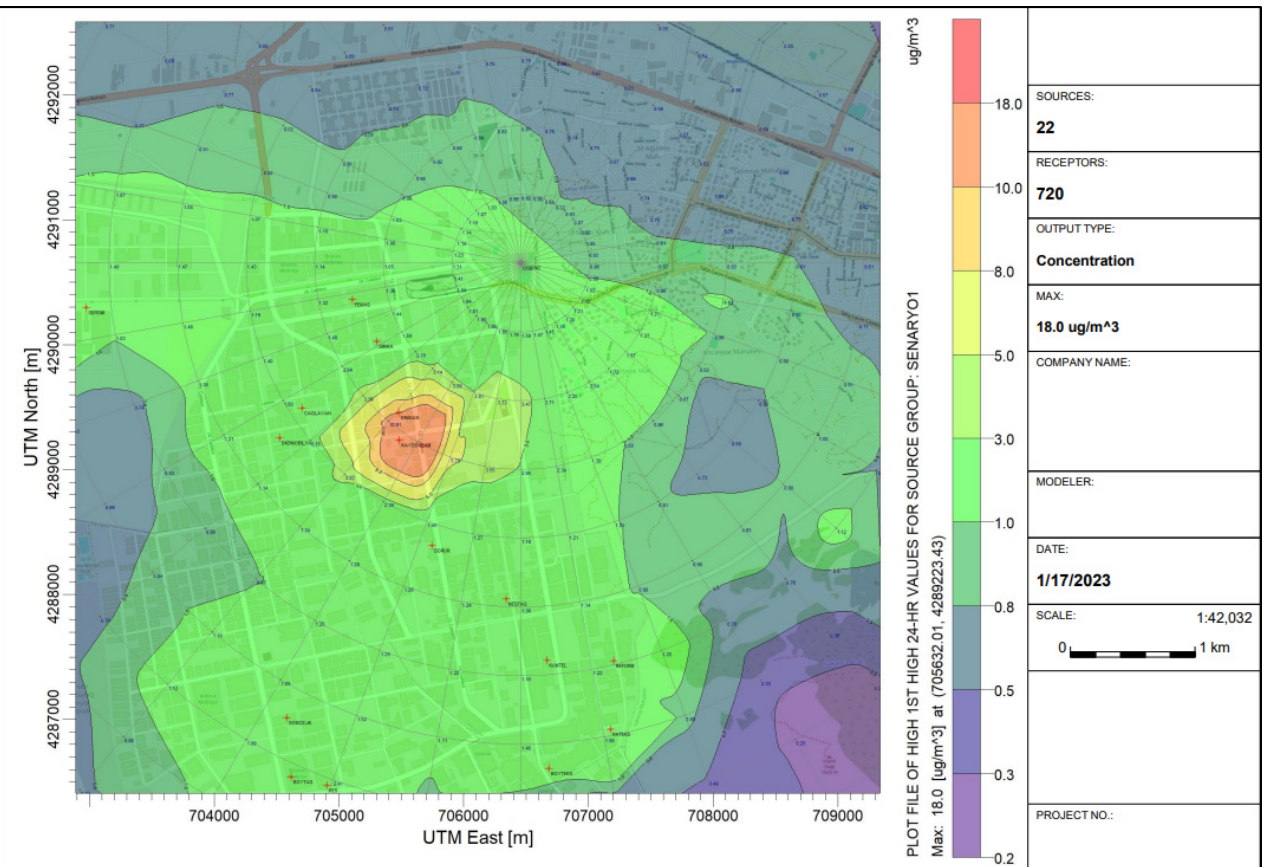
Figure 6. The AERMOD dispersion map created for scenario 1 (Red crosses represent the facilities considered in the model). Table 4. AERMOD modeled PM 10 levels, peak receptor coordinates, and dates/hour for scenarios 1 and 2.